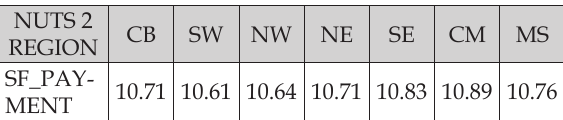
Table 3. SF_PAYMENT – NUTS 2 regions.